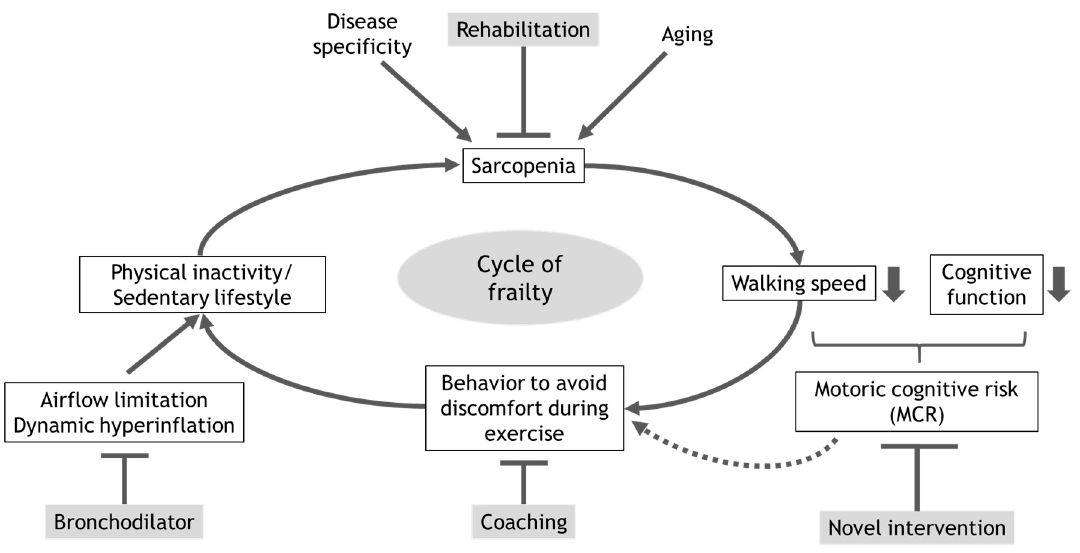
Figure 3. The schematic view of the vicious cycle of frailty / sedentary lifestyle in patients with COPD and potential approaches to attenuate the negative impact of this cycle.